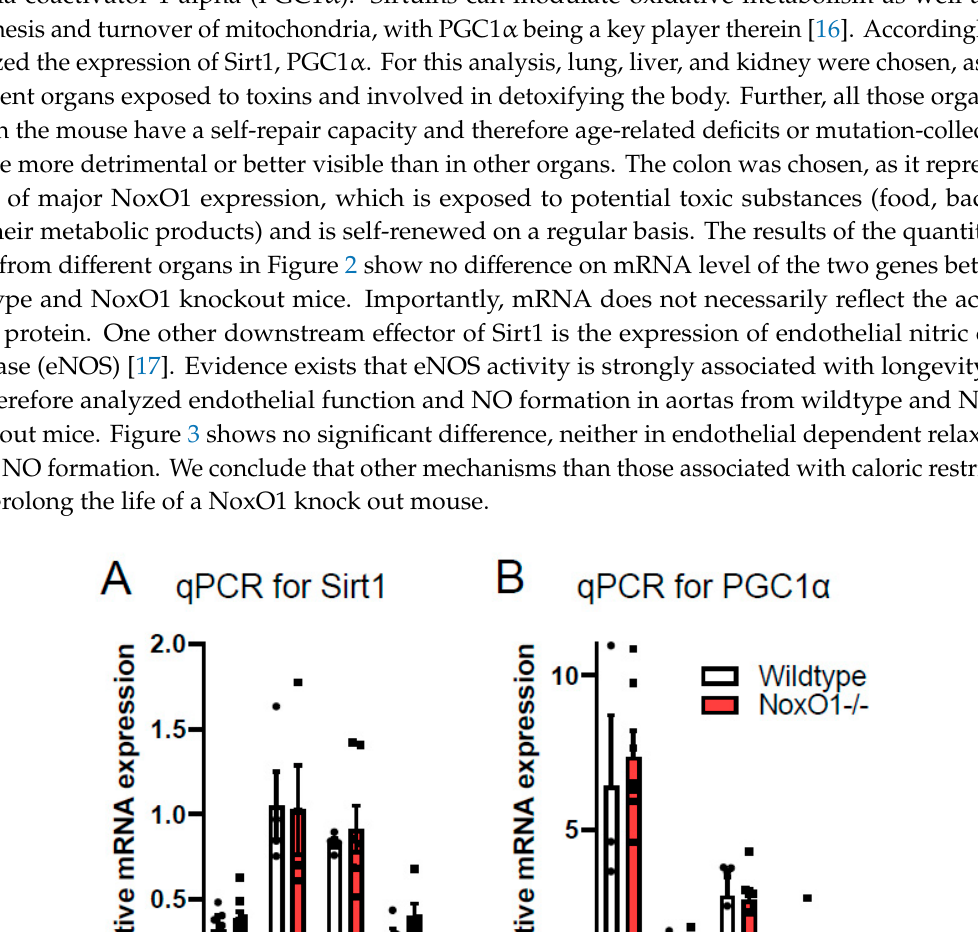
Figure 2. mRNA expression of ( A ) sirtuin1 and ( B ) PGC1 α in the organs indicated. n = 5 (5 male mice at the age of 12 weeks with 4 quantitative PCRs for each organ).